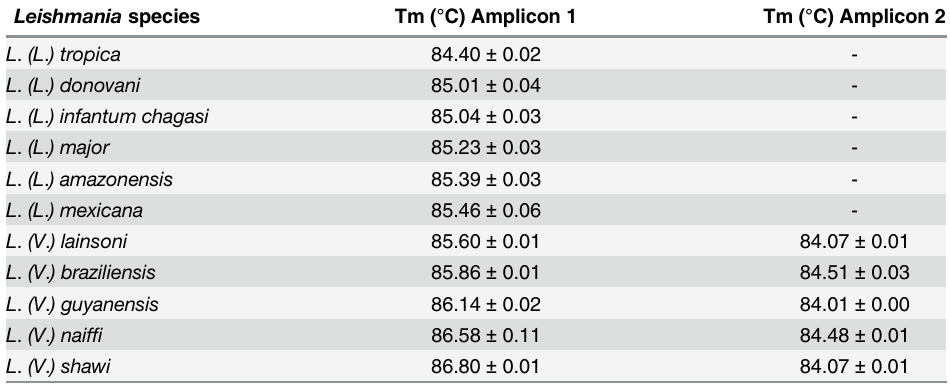
Table 1. Tm values obtained in the HRM analysis targeting the hsp70 gene of different Leishmania species. Fifty ng of genomic DNA from each species was tested in duplicate in three independent experiments.